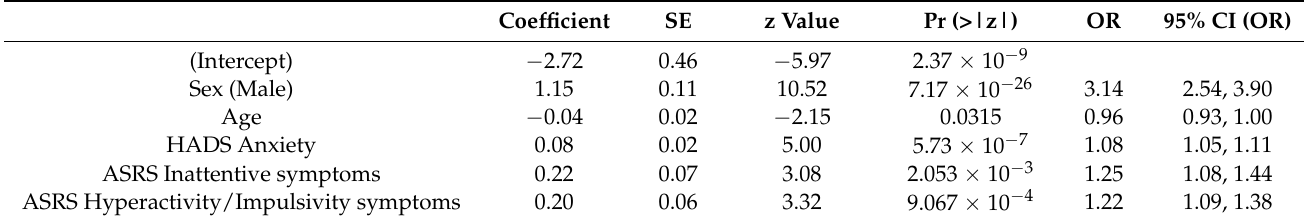
Table 2. Final model with logistic regression output, Odds ratios (OR), and 95% confidence intervals (95% CI) for Odds ratios. HADS: Hospital Anxiety and Depression Scale, ASRS: Adult ADHD Self Report Scale